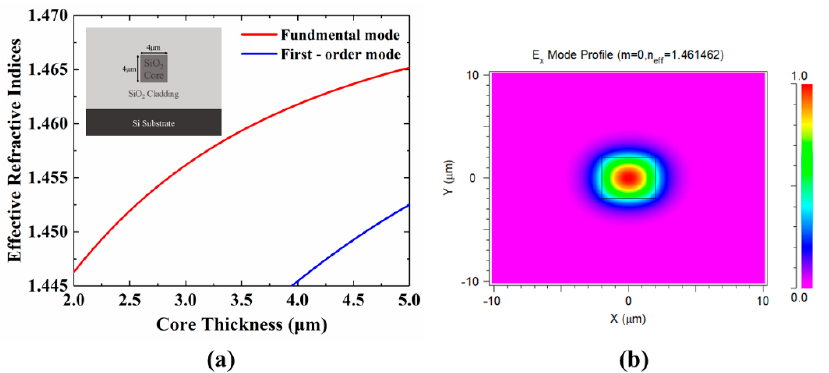
Figure 1. ( a ) Relations between the core thickness and the effective refractive indices at 1550 nm. The inset shows the cross-section of waveguide. ( b ) The mode profile of the waveguide simulated through BPM method.